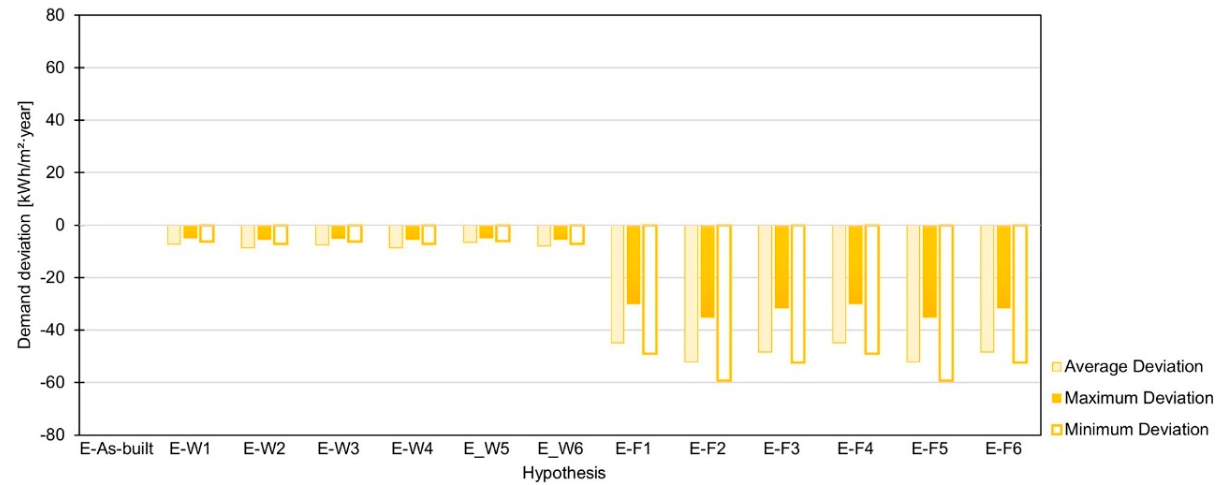
Figure 14. Demand deviation per m 2 (average, maximum, and minimum) regarding the as-built state.